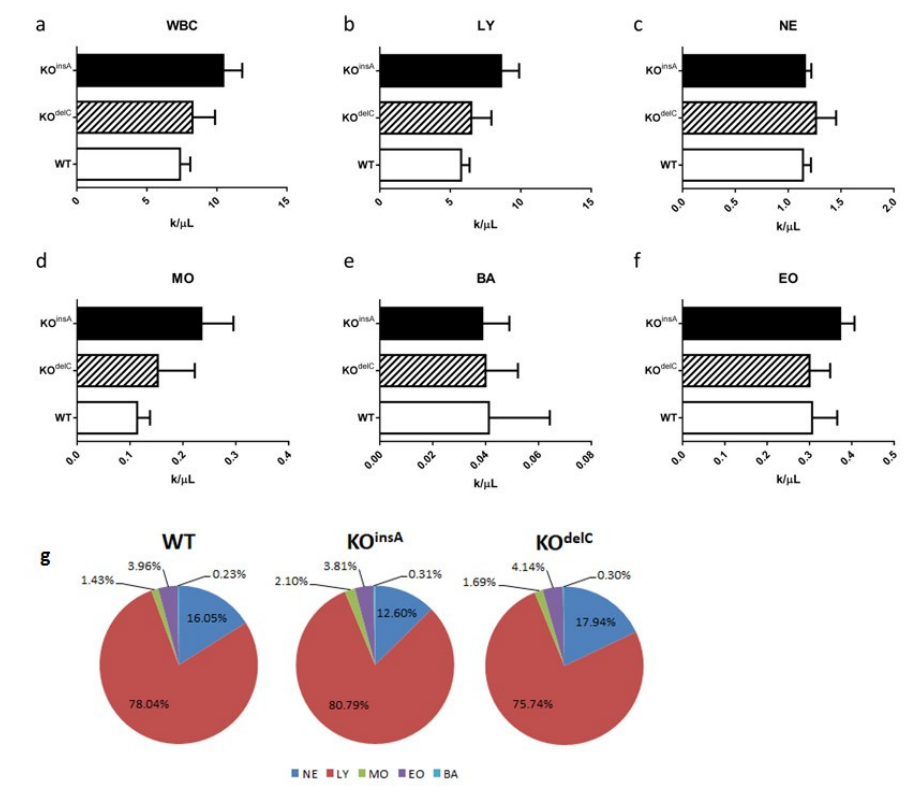
Figure 5. Rat white blood cells (WBC) parameters and WBC differential of WT and TAAR9-KO rats. ( a – f ) Comparative analyzes revealed minimal alterations in immune parameters: ( a ) white blood cells (WBC) in total, ( b ) lymphocytes (LY), ( c ) neutrophils (NE), ( d ) monocytes (MO), ( e ) basophils (BA), ( f ) eosinophils (EO). Data are mean ± SEM; ( g ) diagrams present no changes in both TAAR9-KO groups in comparison to WT rats. NE: neutrophils, LY: lymphocytes, MO: monocytes, EO: eosinophils; BA: basophils. Data are mean (%), n = 7 per group.